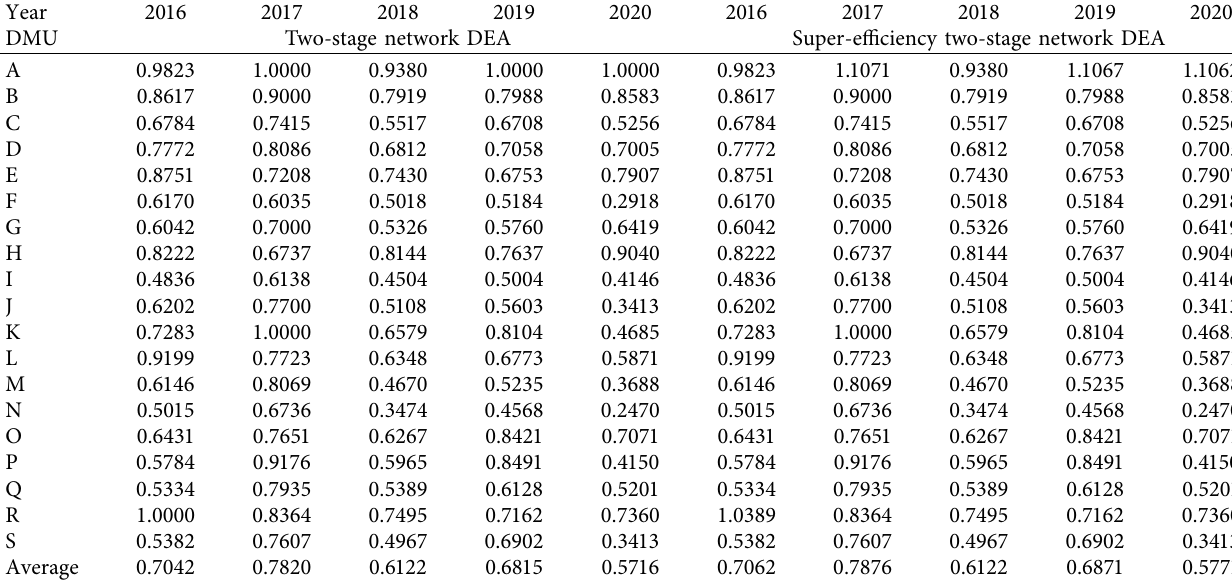
Table 4: Measurement results of various banks